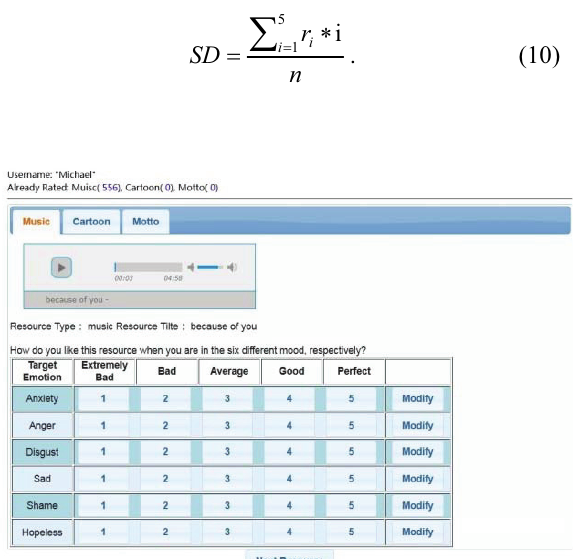
Fig. 3. This is a sample profile from